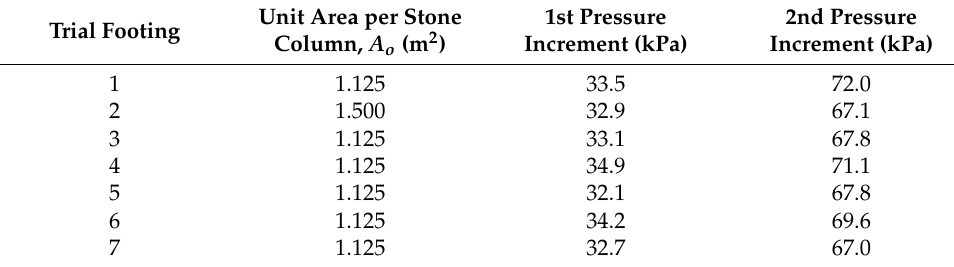
Table 2. Load increments applied to trial footings at